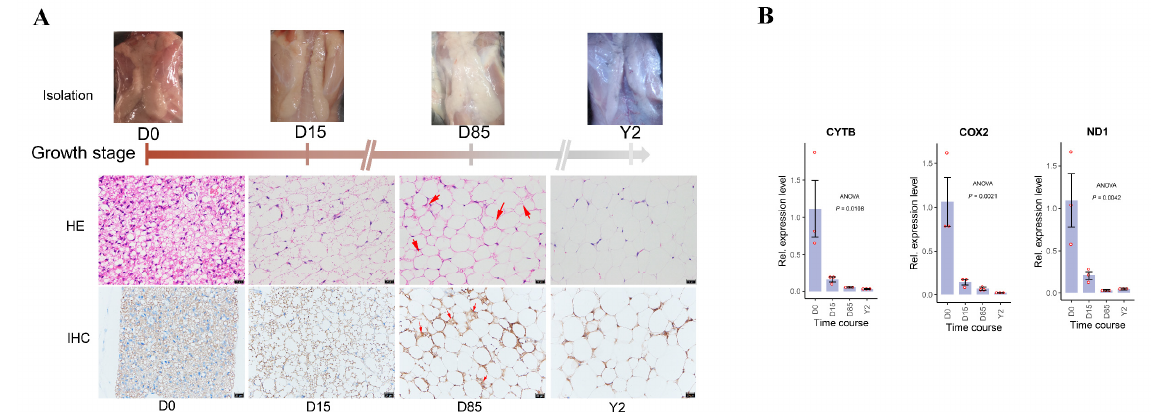
Figure 1. Histological characterization of ARBW in rabbits. ( A ) Isolation, H&E staining and immunohistochemistry (IHC) of rabbit iATs at four stages. The upper panel indicates the biopsy of the iATs, the middle panel indicates the H&E staining results of the iATs, the bottom panel indicates the IHC results of iATs. The scale bar: 20 μ m. The red arrows in H&E and IHC results indicate the multilocular adipocytes in D85. ( B ) The expression levels of mitochondrial genes were detected at four growth stages during rabbit iAT whitening using qRT-PCR. The expression was normalized to the ACTB gene and D0. The data shows the means of three independent experiments. Two technical replicates were set for one individual experimental replicate. The “Rel.” represents “Relative”.